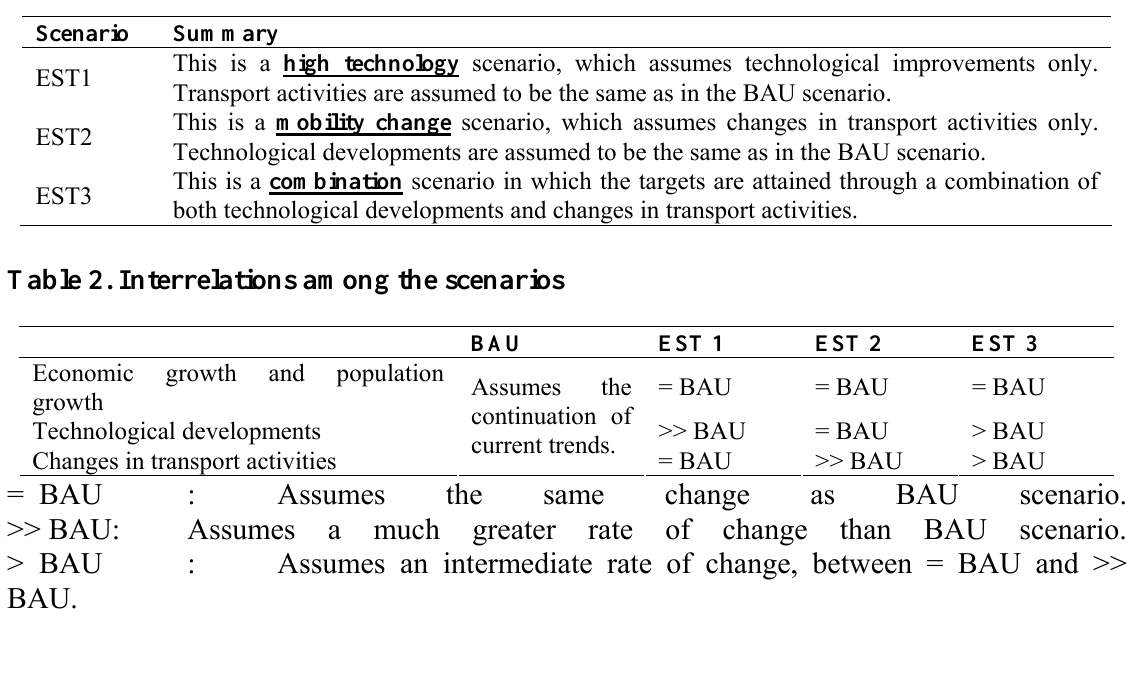
Table 1. Scenarios for achieving the targets